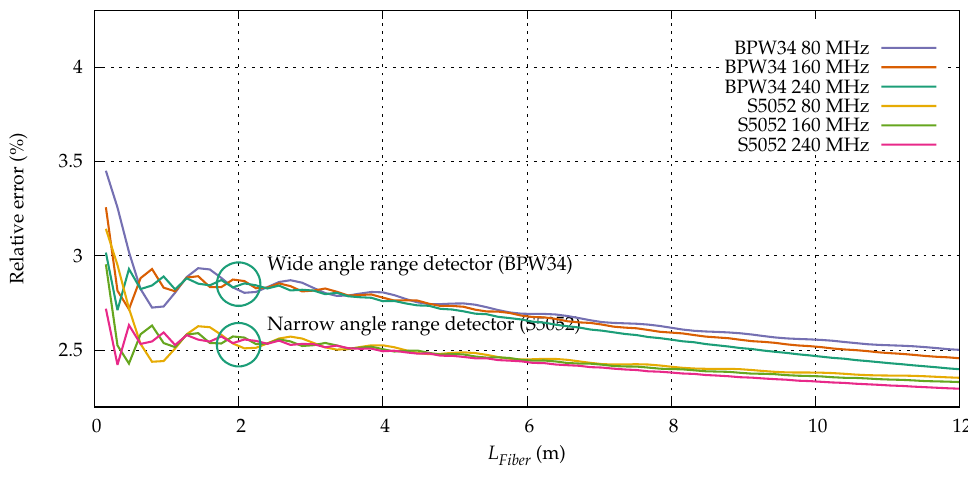
Figure 16. Simulated relative error considering